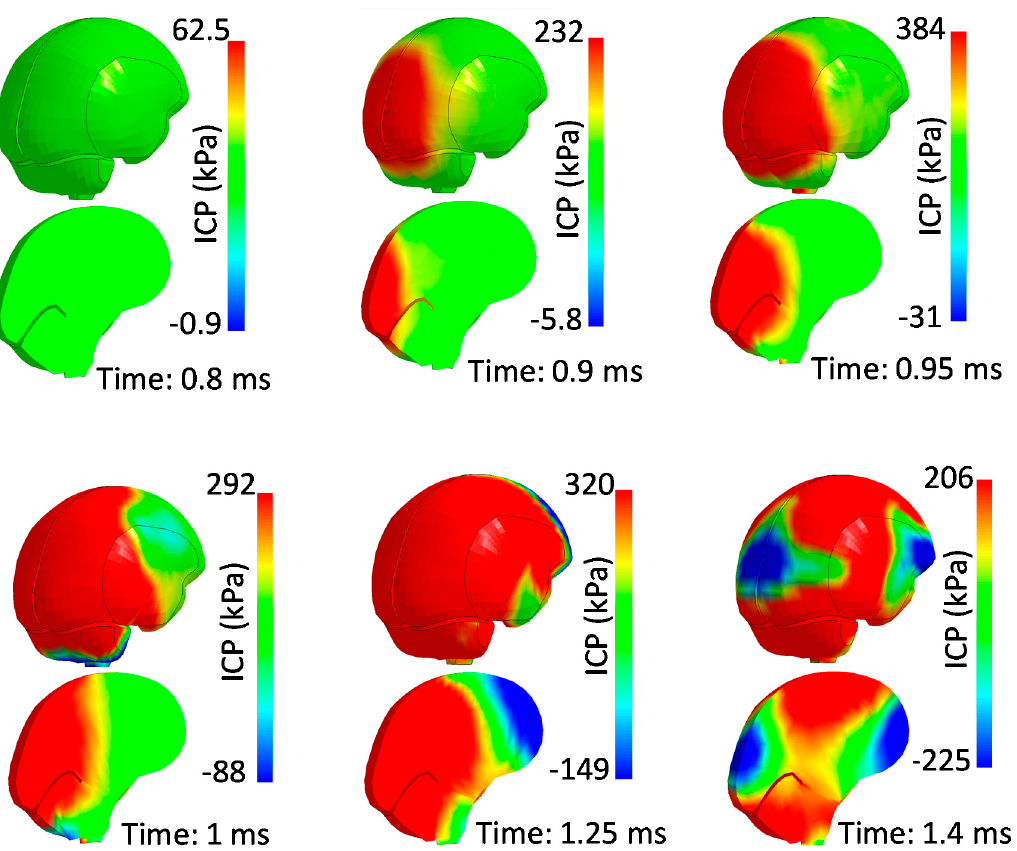
Figure 5. Intracranial pressure (ICP) (kPa) contours in the brain for the protected head in heavy blast for whole brain and also cross-sectional view.